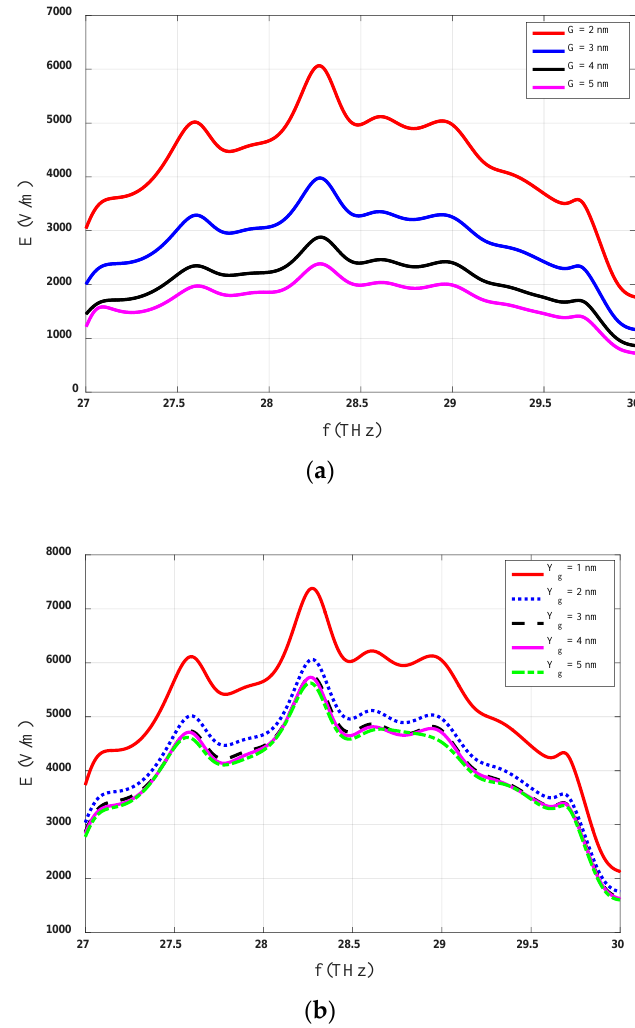
Figure 3. Effect of MIM dimensions ( a ) gap length (G) and ( b ) width (Yg) of insulator on the induced electric field.